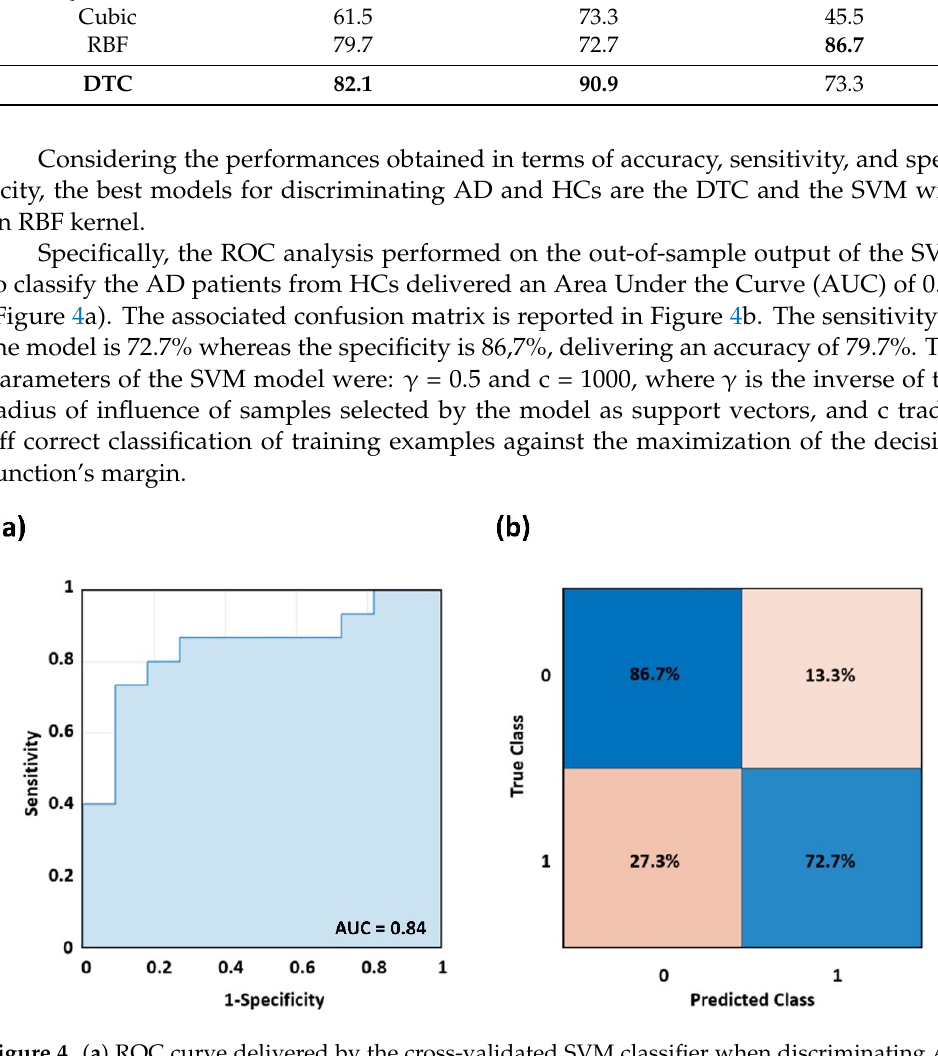
Figure 4. ( a ) ROC curve delivered by the cross-validated SVM classifier when discriminating AD and HCs, and ( b ) associated confusion